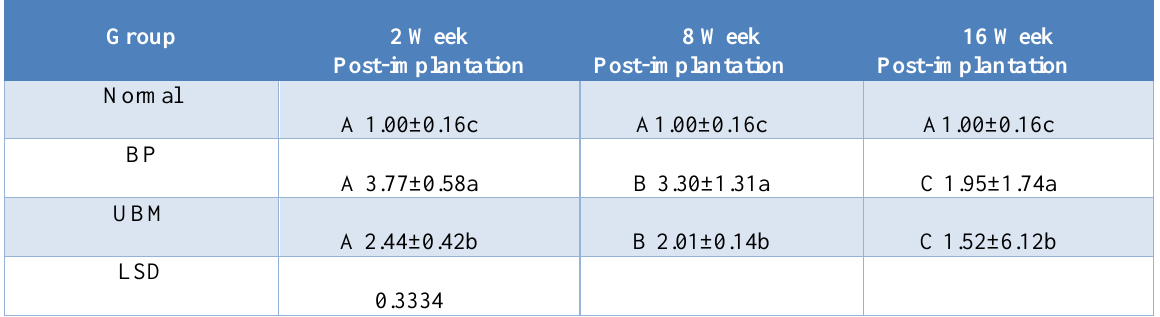
Table,4: The means±SE values of VEGF in Control, BP and UBM groups at different period post-treatment.